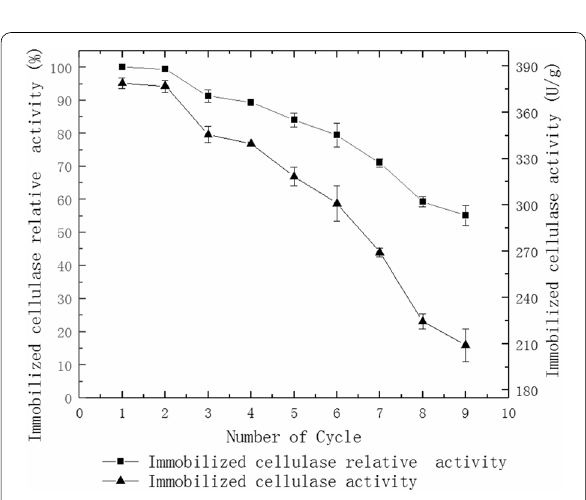
Fig. 8 Reusable hydrolysis CMC by the immobilized